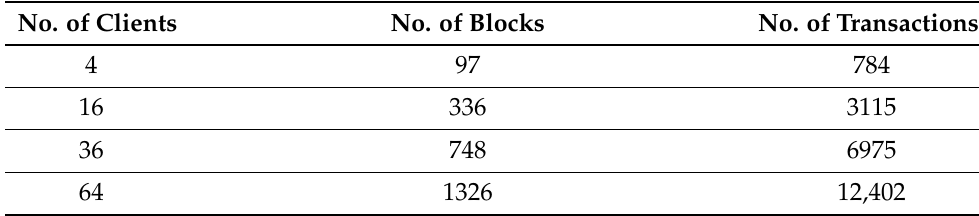
Table 6. Verification of the signature without the orchestration tool: multi-host-solo